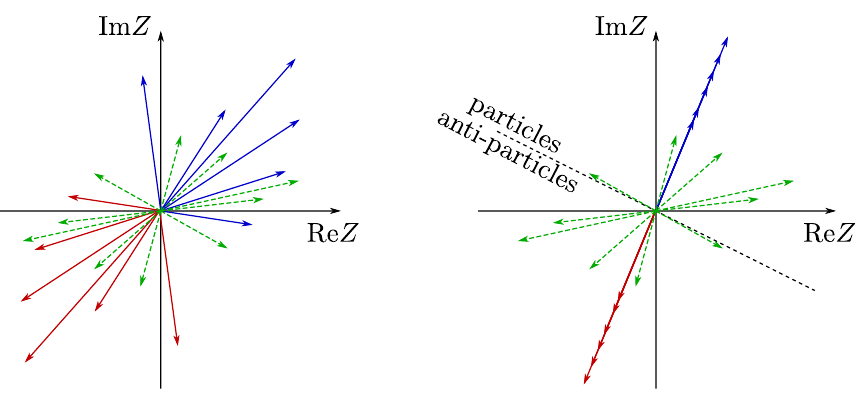
Figure 4. We depict an example of the central charges of BPS states in a 2d-4d system, on the left, at a generic point in the Coulomb branch of the 4d theory, and on the right at the Roman locus. In the latter case the 4d central charges de(cid:12)ne a choice of half-plane (dashed black line), centered around the critical ray, which distinguishes 2d-4d particles from their CPT conjugates. We use solid arrows to denote central charges of the 4d theory, whereas dashed arrows are those of 2d-4d BPS